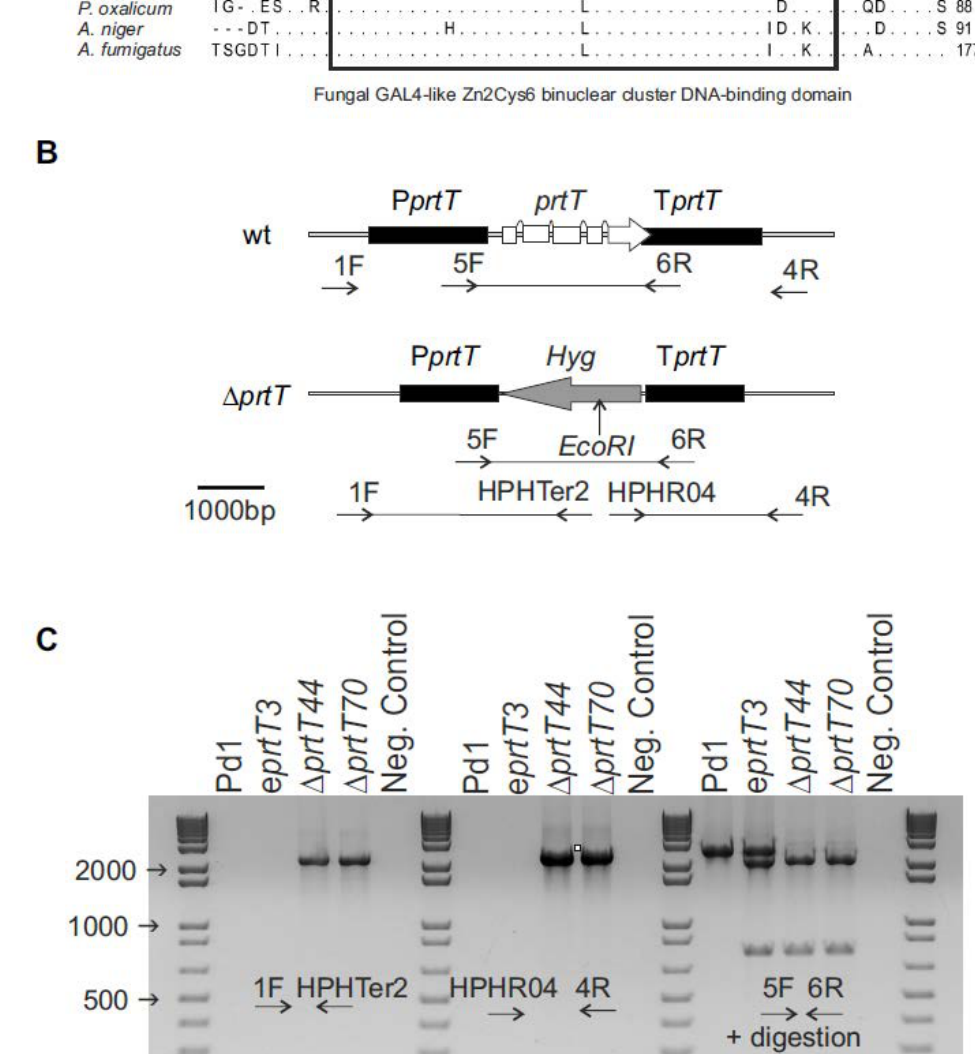
Figure 1. Deletion of Penicillium digitatum prtT . ( A ) A fungal-specific Zn 2 Cys 6 binuclear DNA binding cluster (black box) located at the N-terminal region of P. digitatum PrtT. The GeneBank accession number of aligned homologs are as follows: Penicillium rubens Wisconsin 54-1255 (XP_002565177), Penicillium oxalicum 114-2 (EPS29021), Aspergillus niger CBS 513.88 (XP_001402055.1), and Aspergillus fumigatus var. RP-2014 (KEY83531). Identical amino acids are indicated by a dot ‘ · ’. ( B ) Diagram of the wild type P. digitatum Pd1 and deleted prtT loci, including the diagnostic primers used for checking the deletion (see also Table 1). P prtT : P. digitatum prtT gene promoter; T prtT : P. digitatum prtT gene terminator; Hyg; hygromycin resistance gene. ( C ) Polymerase chain reaction amplification of the wild type Pd1, the ectopic e prtT 3 mutants, and the two knockout ∆ prtT 44 and ∆ prtT 70 mutants with diagnostic